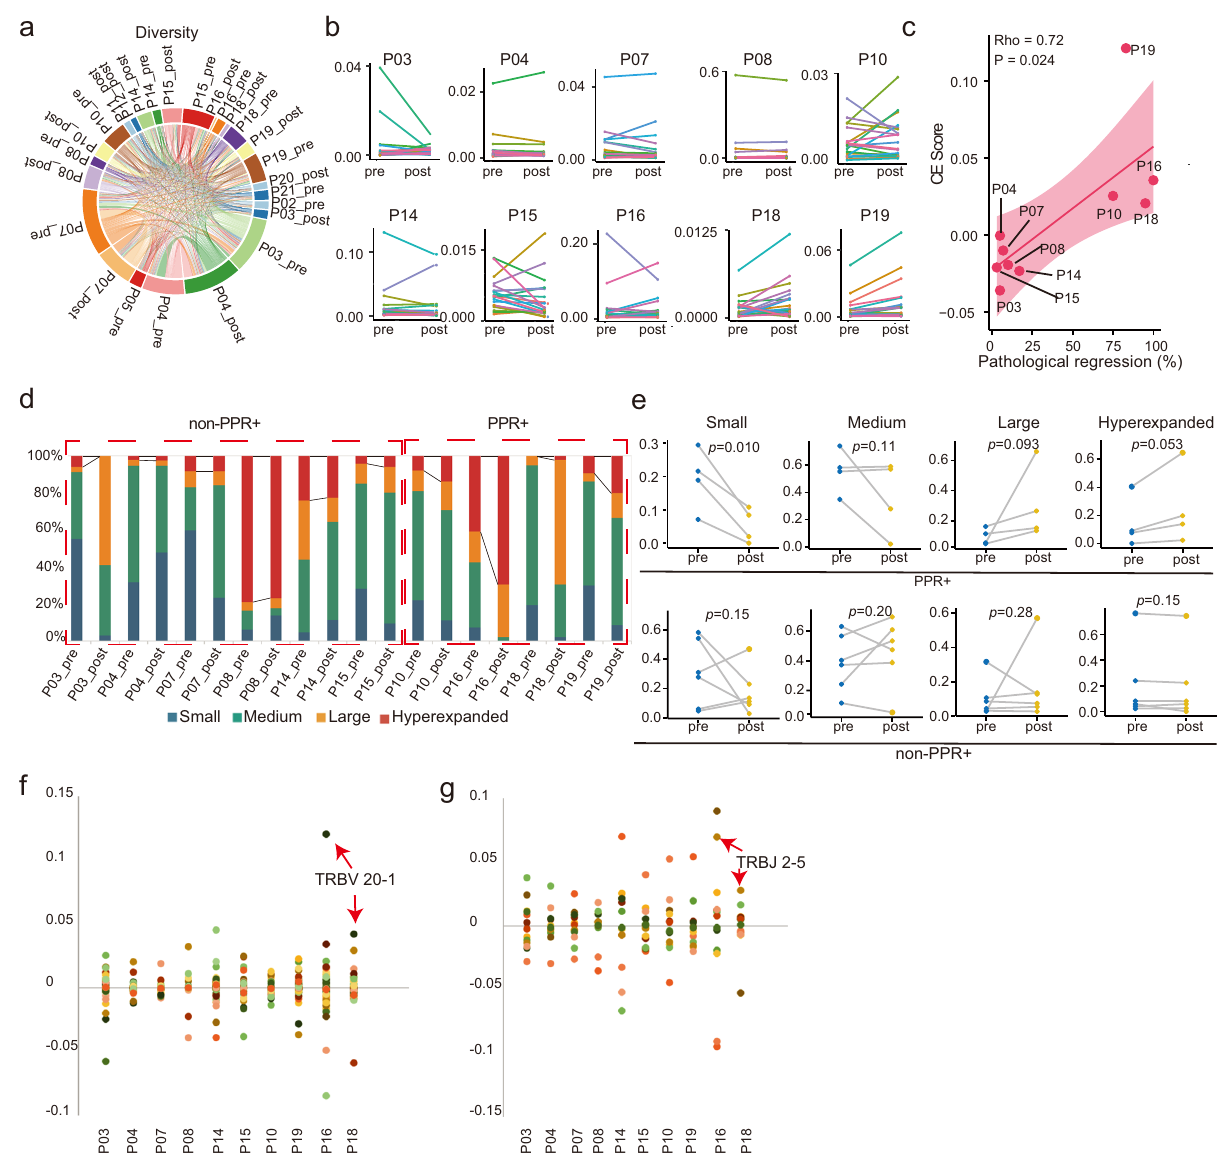
Fig. 6 | T cell repertoire and dynamic changes. a Pairwise overlap circos plot showing total numbers of clonotypes shared between samples in 16 patients. b Abundances of top 20 most frequent TCR clonotypes in each patient pre- and post-treatment. c Correlation between clone expansion scores (CE scores) and percentages of pathological regression. The correlation was accessed by Spear- man ’ s rank correlation coef fi cient (rho). The regression line is red and the shading indicates the 95% con fi dence interval. d Proportion of four TCR